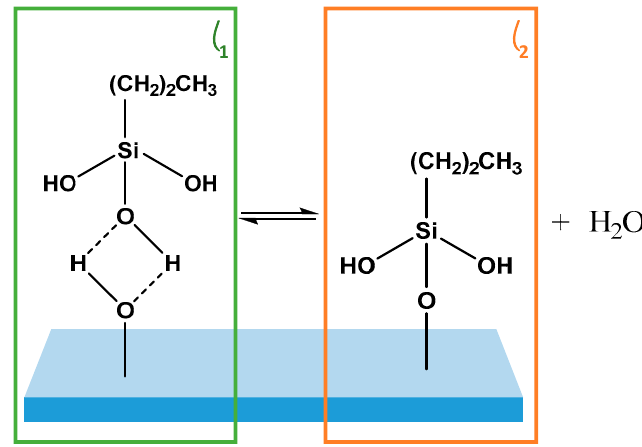
Figure 2. The conversion of hydrogen bound θ 1 represented by a PDMMS monomer ( green ) to θ 2 , a covalently bound PDMMS monomer ( orange ) in the 2-component model.